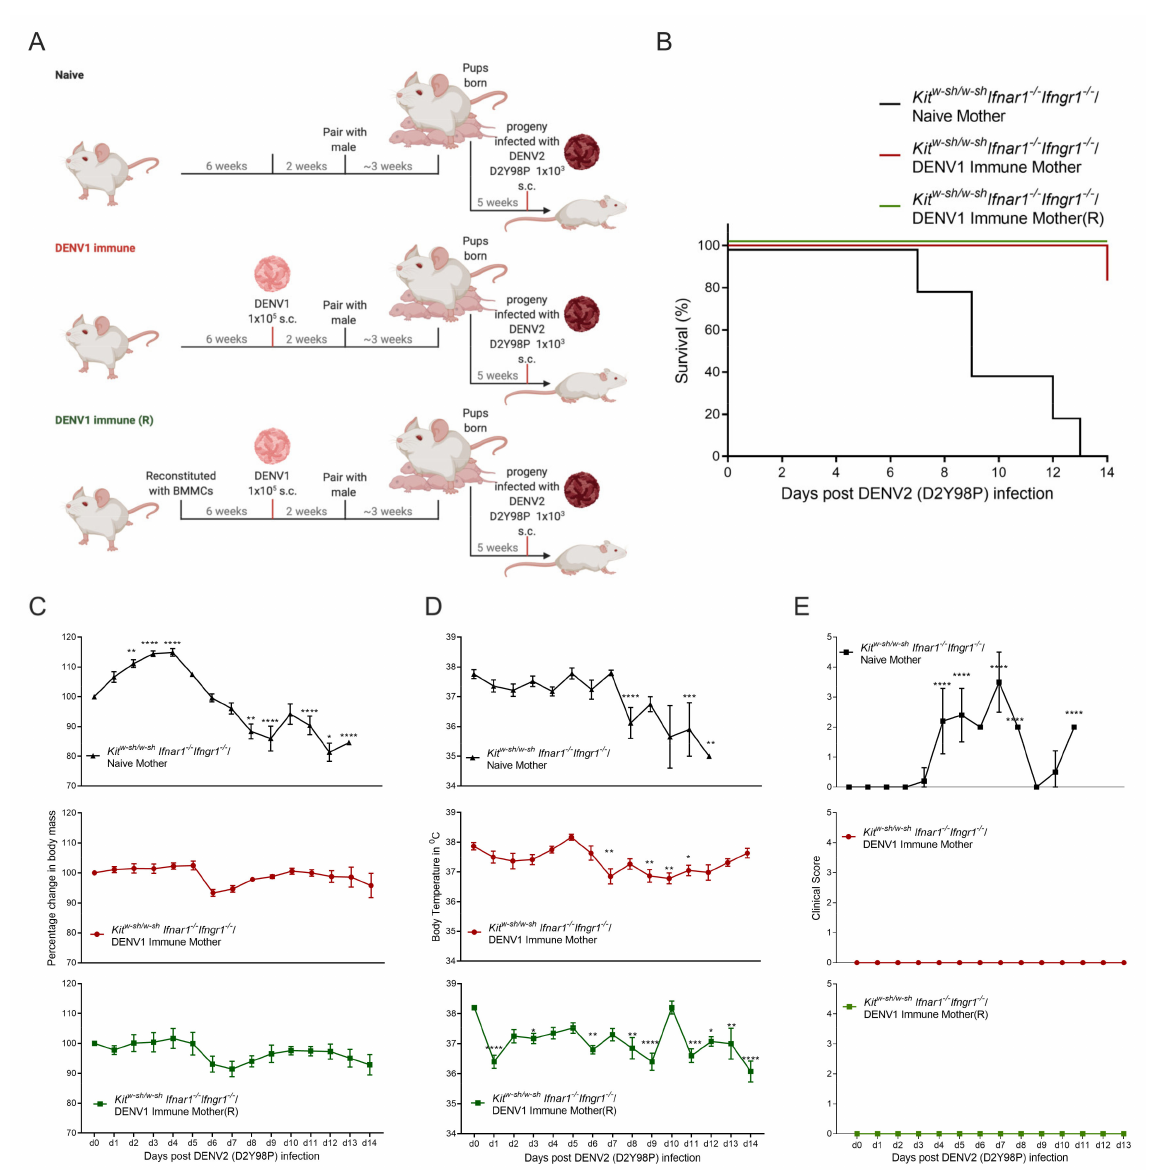
(Figure 4A). Infection of the progeny mice born to naïve Kit W-sh/W-sh Ifnar1 − / − Ifngr1 +/+ mothers, with DENV2(D2Y98P) s.c., resulted in 30% mortality, compared to 90% mortality in Kit W-sh/W-sh Ifnar1 − / − Ifngr1 − / − mice (Figure 4B) and lower clinical score (Figure 4C), indicating the protective property of IFN- γ signaling. Mice born to DENV1 immune Kit W-sh/W-sh Ifnar1 − / − Ifngr1 +/+ dams were also more susceptible to subcutaneous DENV2 challenge and showed 50% mortality, suggesting enhancement of the disease (Figure 4D) similar to the previously established AG129 mice model [39]. This points to a critical role of IFN- α deficiency in the presence of IFN- γ in leading to enhancement of disease.